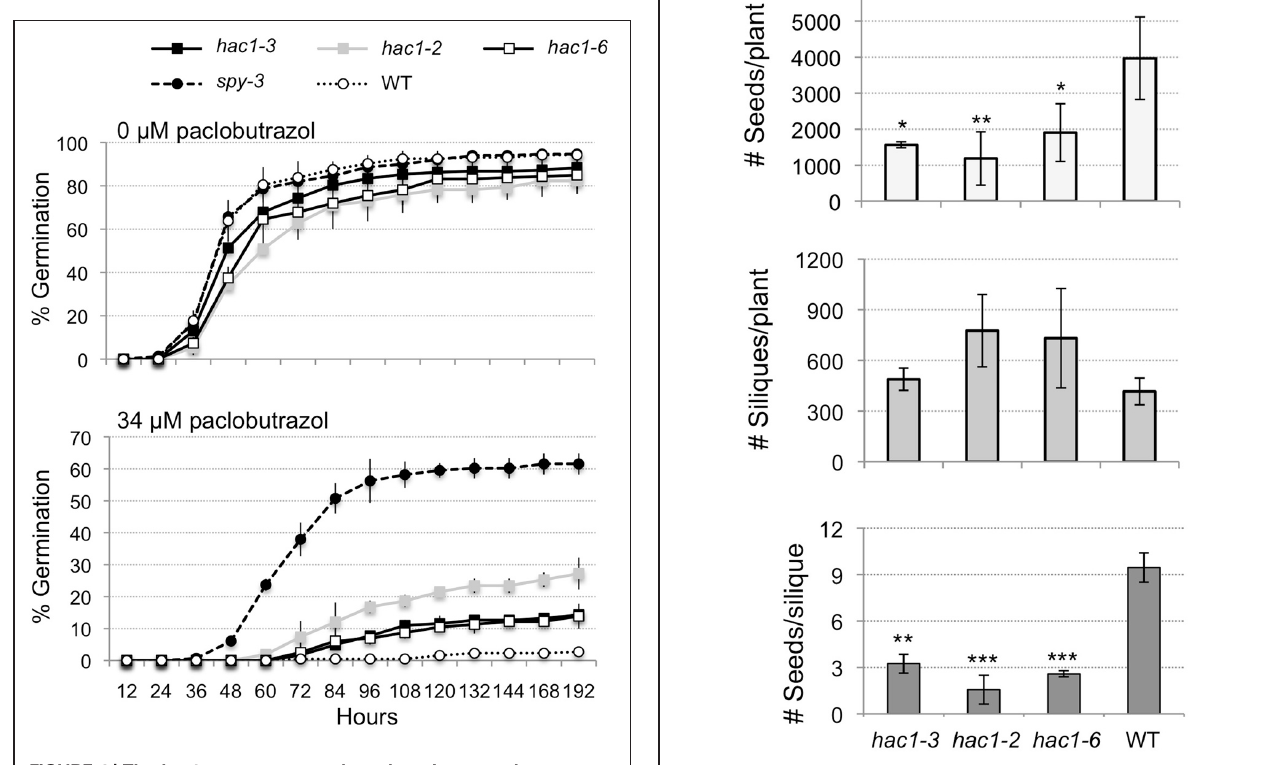
FIGURE 5 | Mutations in HAC1 reduce seed production. Mutant and wild-type plants were grown to maturity. The numbers of siliques on each plant were counted. Siliques were then collected from each plant and the total number of seeds produced per silique and per plant determined. Error bars indicate standard deviations. Mutant and wild-type results differed with: ∗ p < 0 . 1; ∗∗ p < 0 . 05; or ∗∗∗ p < 0 . 01, according to a Student’s t -test. N = 2 ( hac1-3 , wild-type, WT) or 3 ( hac1-2 , hac1-6